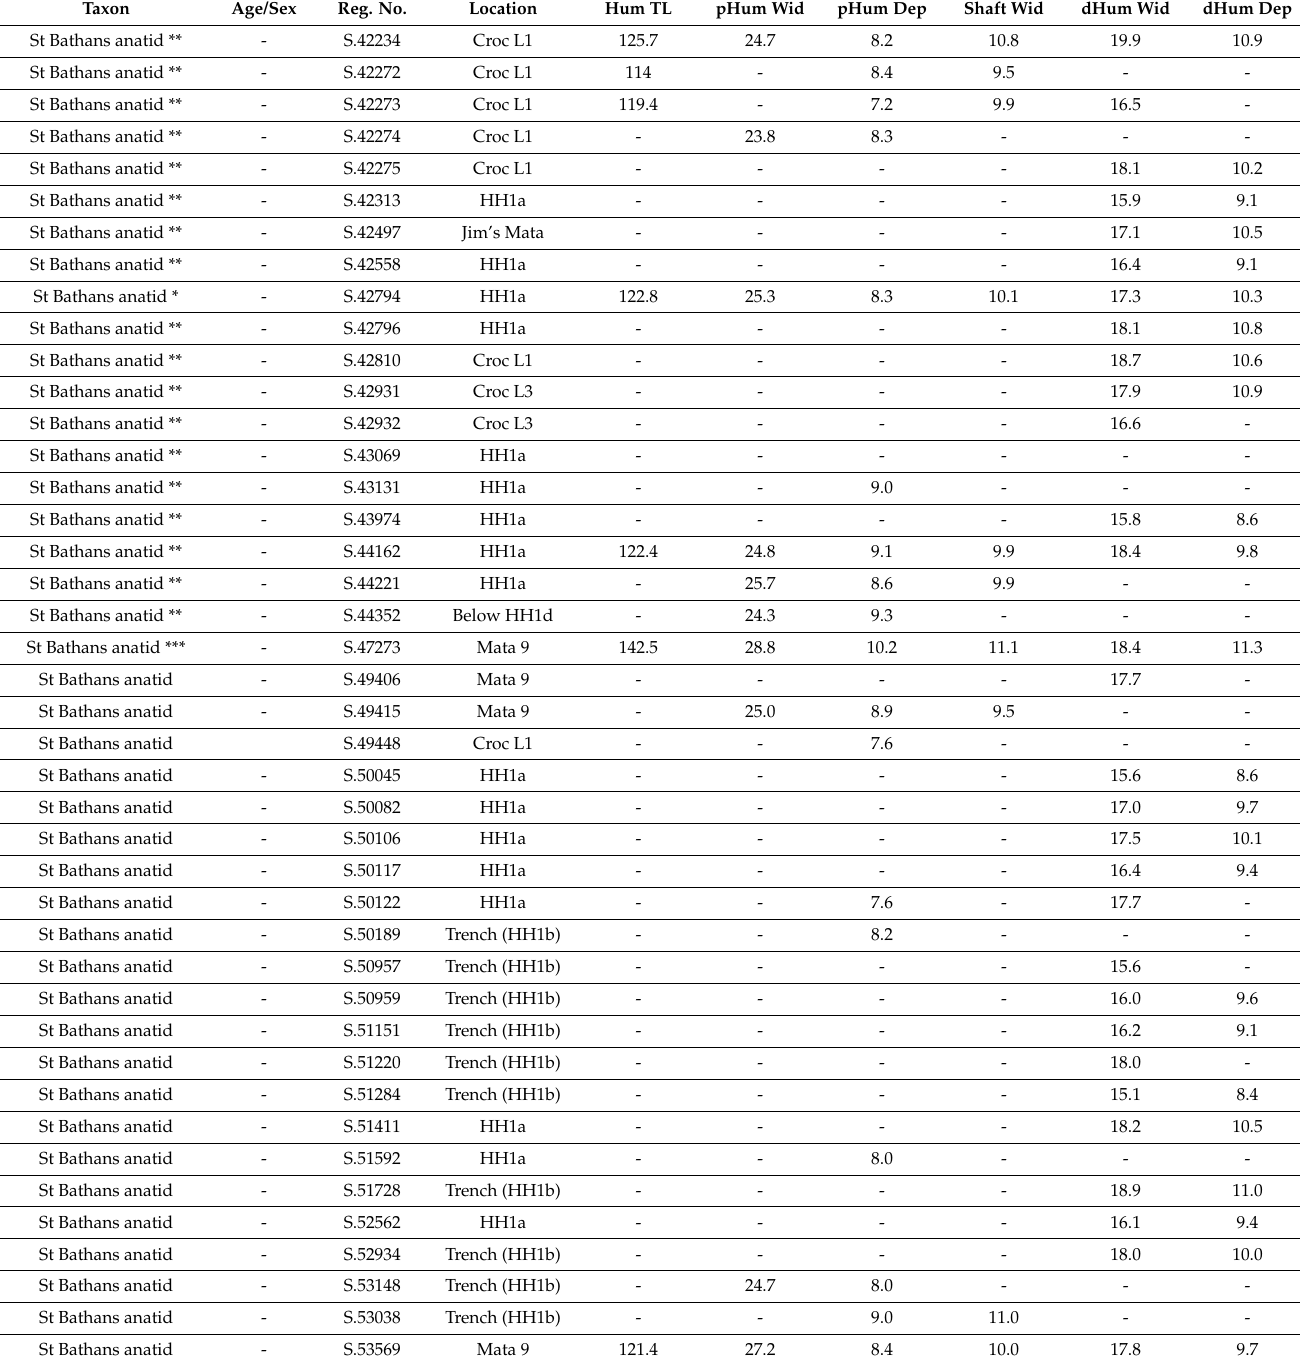
Table A1. Measurements (in mm) of humeri of modern Tadorna variegata and large fossil St Bathans anatids. The acronym NMNZ is omitted from OR. and S. registration numbers for brevity. See Worthy et al. [2] and Schwarzhans et al. [4] for fossil location details. Abbreviations: ad: